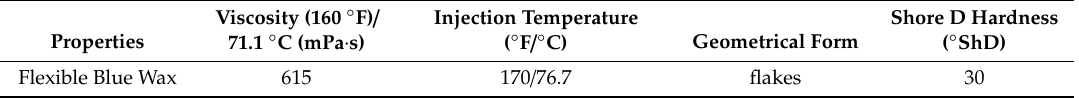
Table 1. Selected physical properties of flexible polyethylene (PE) wax